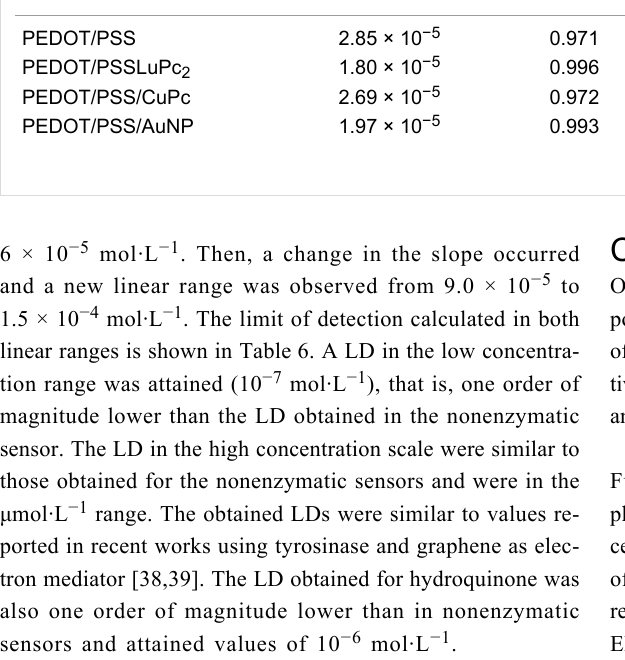
Table 6: Limit of detection and regression coefficients obtained for catechol and hydroquinone using the cathodic (LD C ) peaks using biosensors.